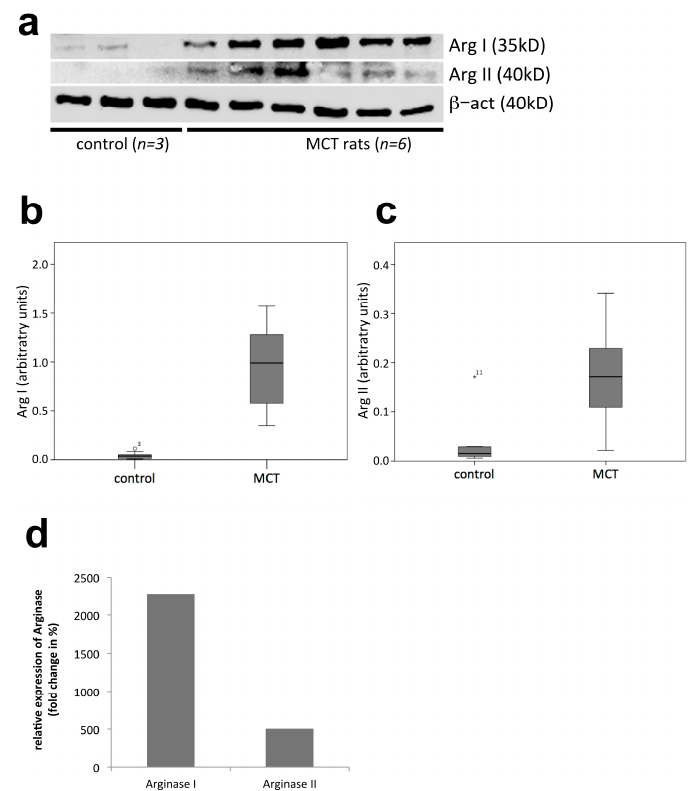
Figure 4. Western Blot and semi-quantitative analysis of Arginase I and II expression in PH rats (MCT group, p = 8) compared to controls ( p = 9): ( a ) representative Western Blot experiment showing increased expression of arginase I and arginase II in MCT treated compared to sham-treated control rats ( β -actin served as housekeeping protein); ( b – d ) software-based densitometric semi-quantitative analysis of arginase I and II expression normalized to β -actin. Data are presented as means and SD.